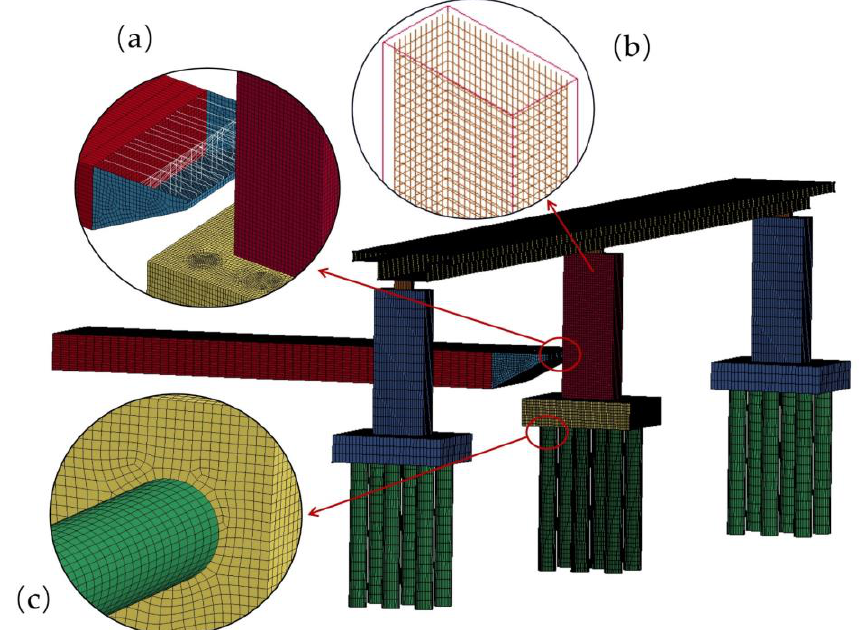
Figure 4. The FE models of barge and whole bridge : ( a ) trusses; ( b ) steel reinforcement; ( c ) mesh dividing of the connection between pile cap and pile foundation. Table 5. Element types and material parameters of barge model. Table 6. Elements types and material parameters of whole bridge